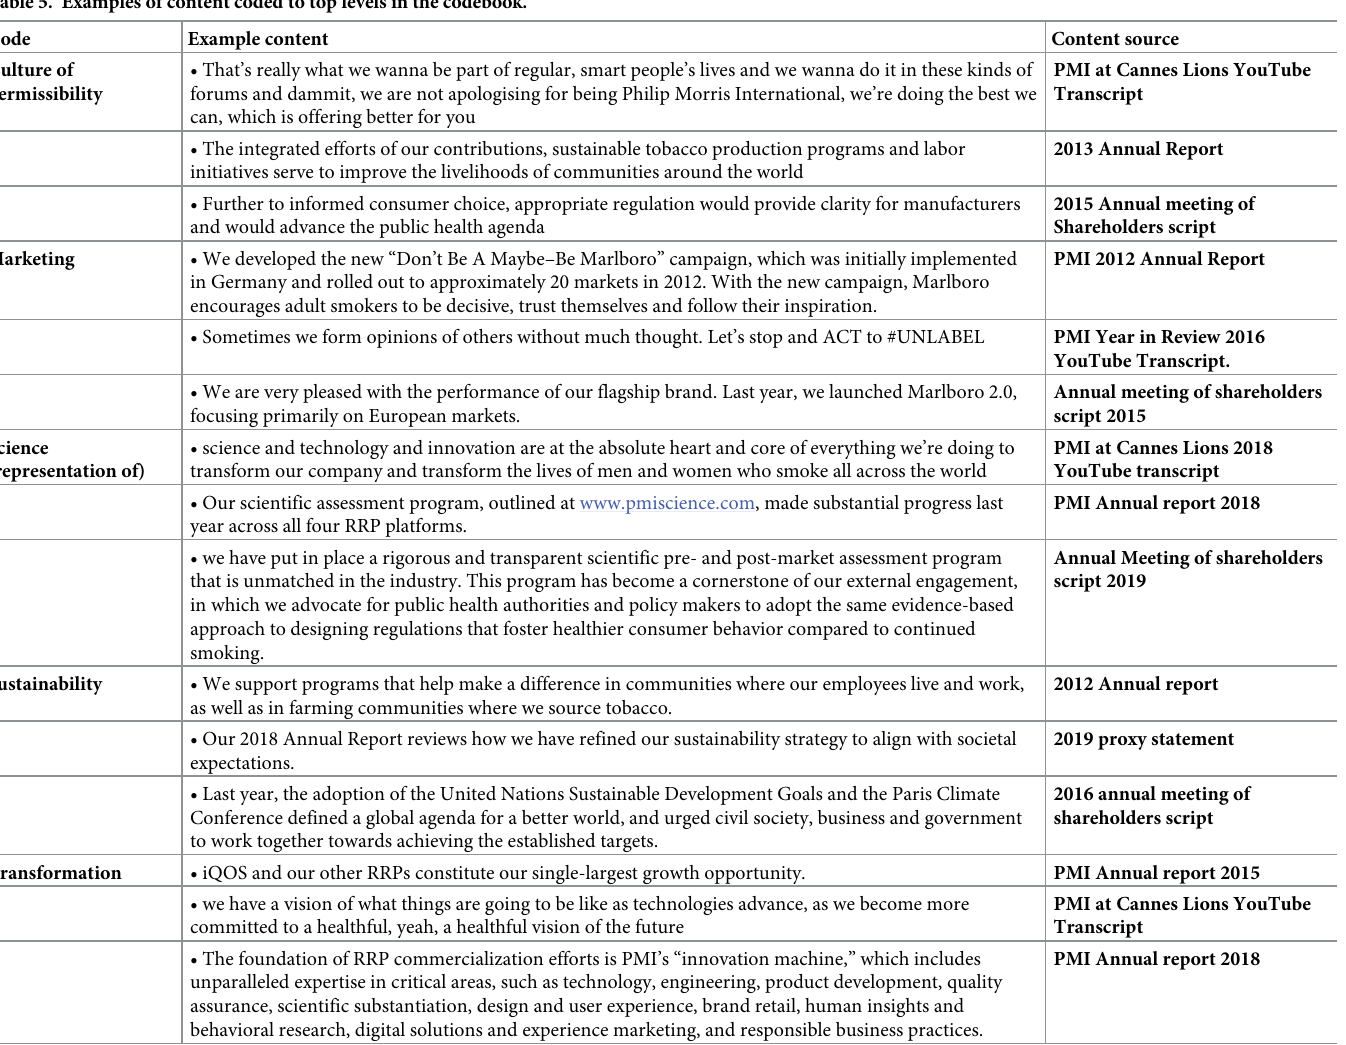
Table 5. Examples of content coded to top levels in the